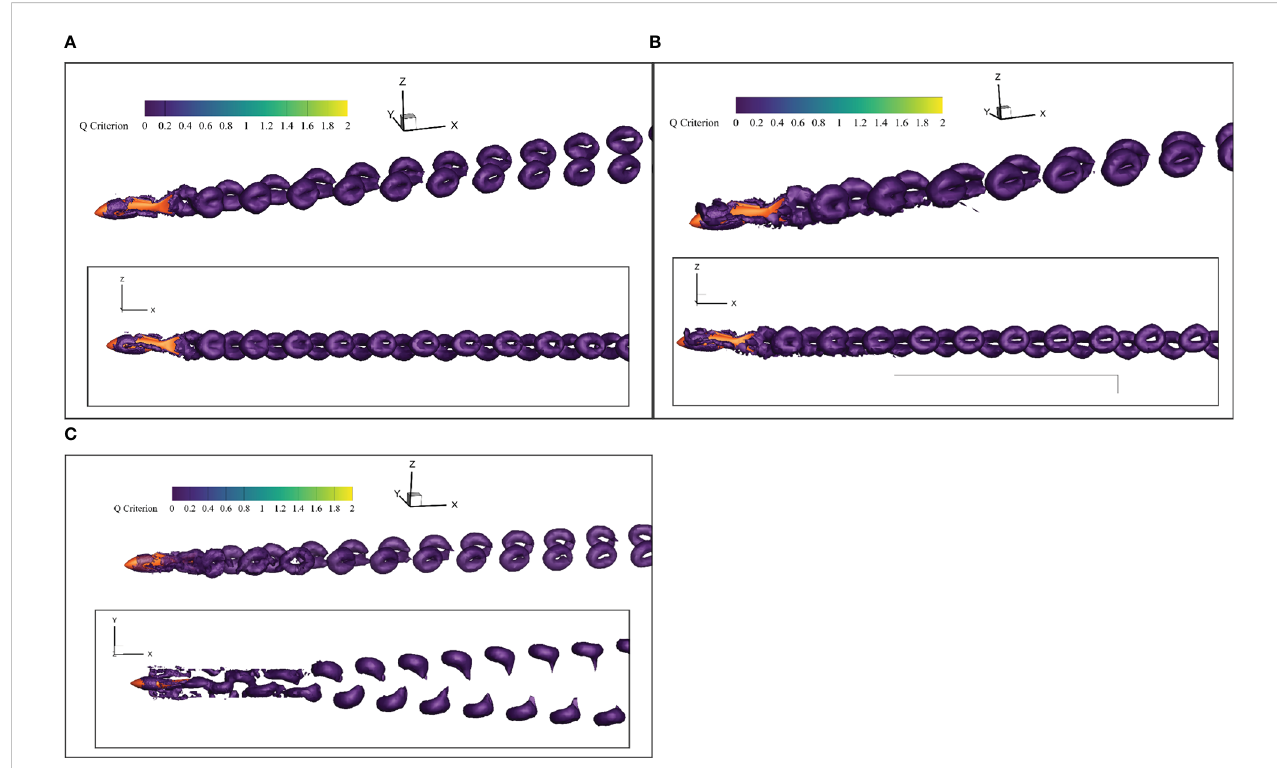
FIGURE 14 Vortex distribution of the research domain. (A) In Open Water (B) Near Undulating Seabed (C) In Narrow